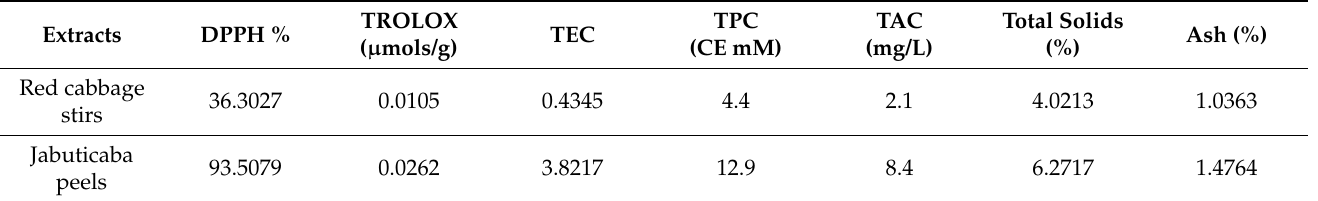
Table 3. Extracts’ antioxidant capacity (total phenolic content (TPC) in catechin equivalent (CE), total anthocyanin content (TAC): TAC, DPPH: scavenging %, Equivalent Trolox and TEC: antioxidant capacity in TROLOX